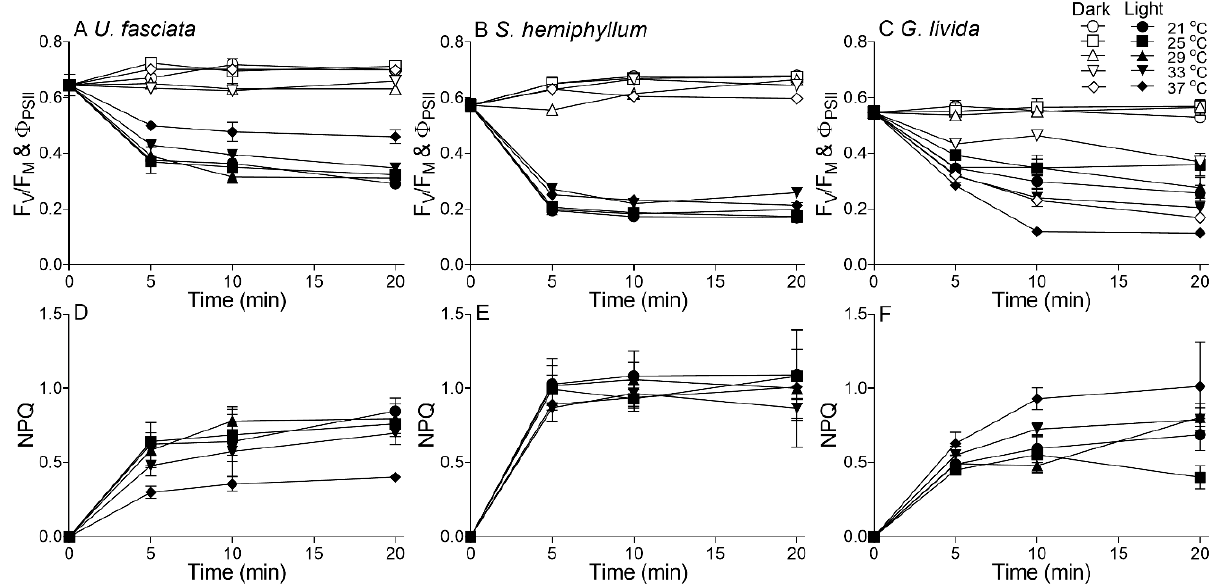
Figure 4. Time-series changes of PS II photochemical quantum yield (( A – C ); Φ PS II under light, or F V /F M under dark) and non-photochemical quenching (( D – F ); NPQ) of ( A , C ) U. fasciata , ( B , D ) S. hemiphyllum and ( C , F ) G. livida under temperatures of 21 (field condition), 25, 29, 33 and 37 °C under the dark and local-noon light (800 µmol photons m − 2 s − 1 ) conditions. Points show averages of measurements on three independent macroalga thalli, and error bars show the standard deviations ( n = 3), often within symbols.